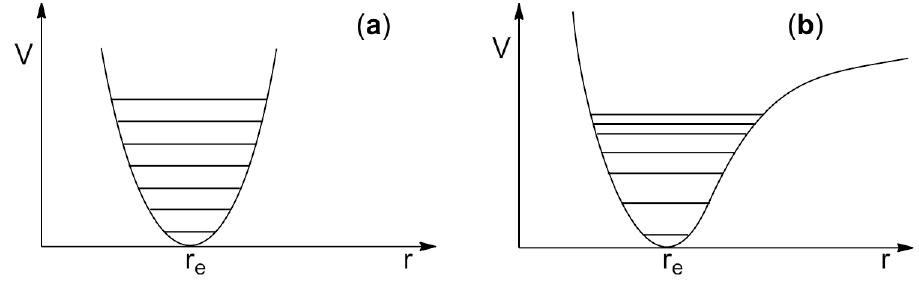
Figure 8. ( a ) The parabolic potential energy as a simple harmonic oscillator and ( b ) the actual potential energy—an anharmonic